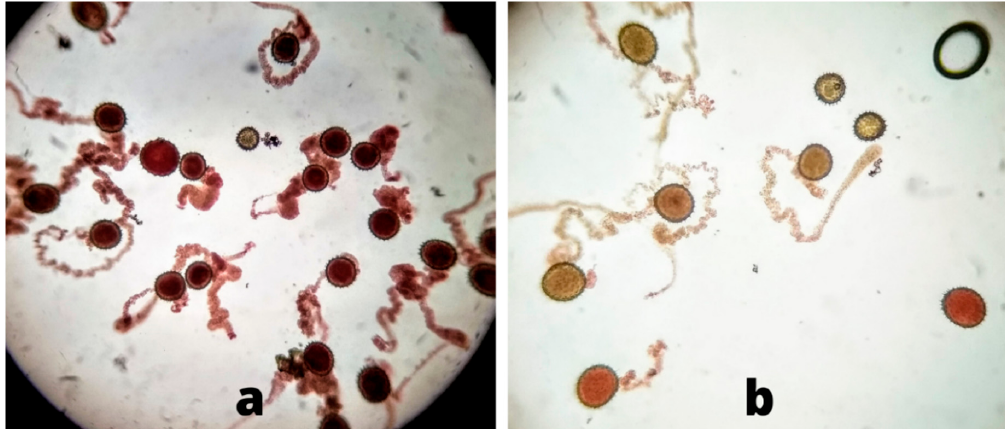
Figure 3. Means averaged across all genotypes to compare top and bottom positions of plants for different traits at maturity. The error bars are standard errors. The letters show Tukey’s mean com- parison where different letters show significant differences between top and bottom positions for each trait. ( a ) PV (Pollen viability), PG (Pollen germination), CMT (Cell membrane thermostability) and boll ret (boll retention), ( b ) Chl. Content (Chlorophyll content), ( c ) Boll wt (Boll weight).